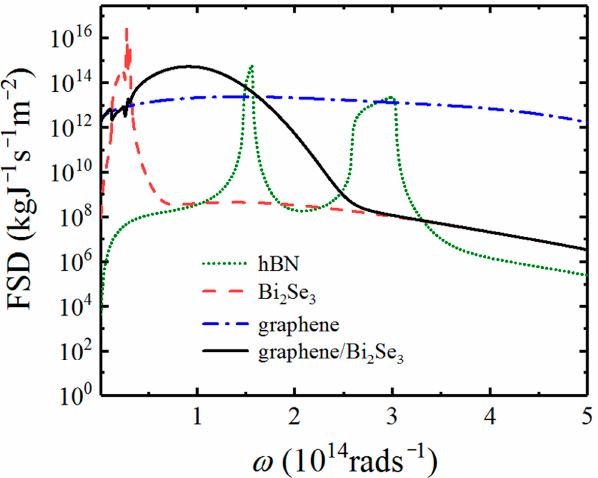
Figure 4. The force spectral densities for different configurations. The parameters used here are the same as those used in Figure 3.